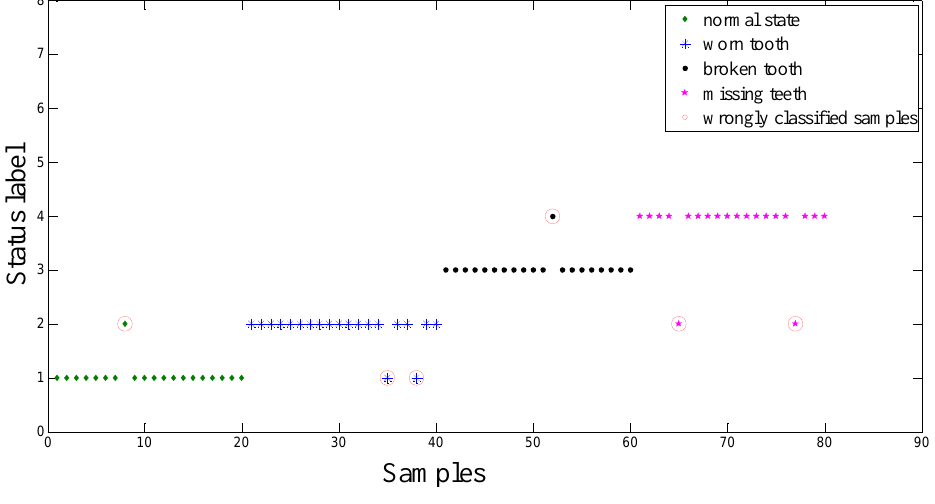
Figure 9. Classification result based on CV-RVM classifier in the bevel gearbox test.